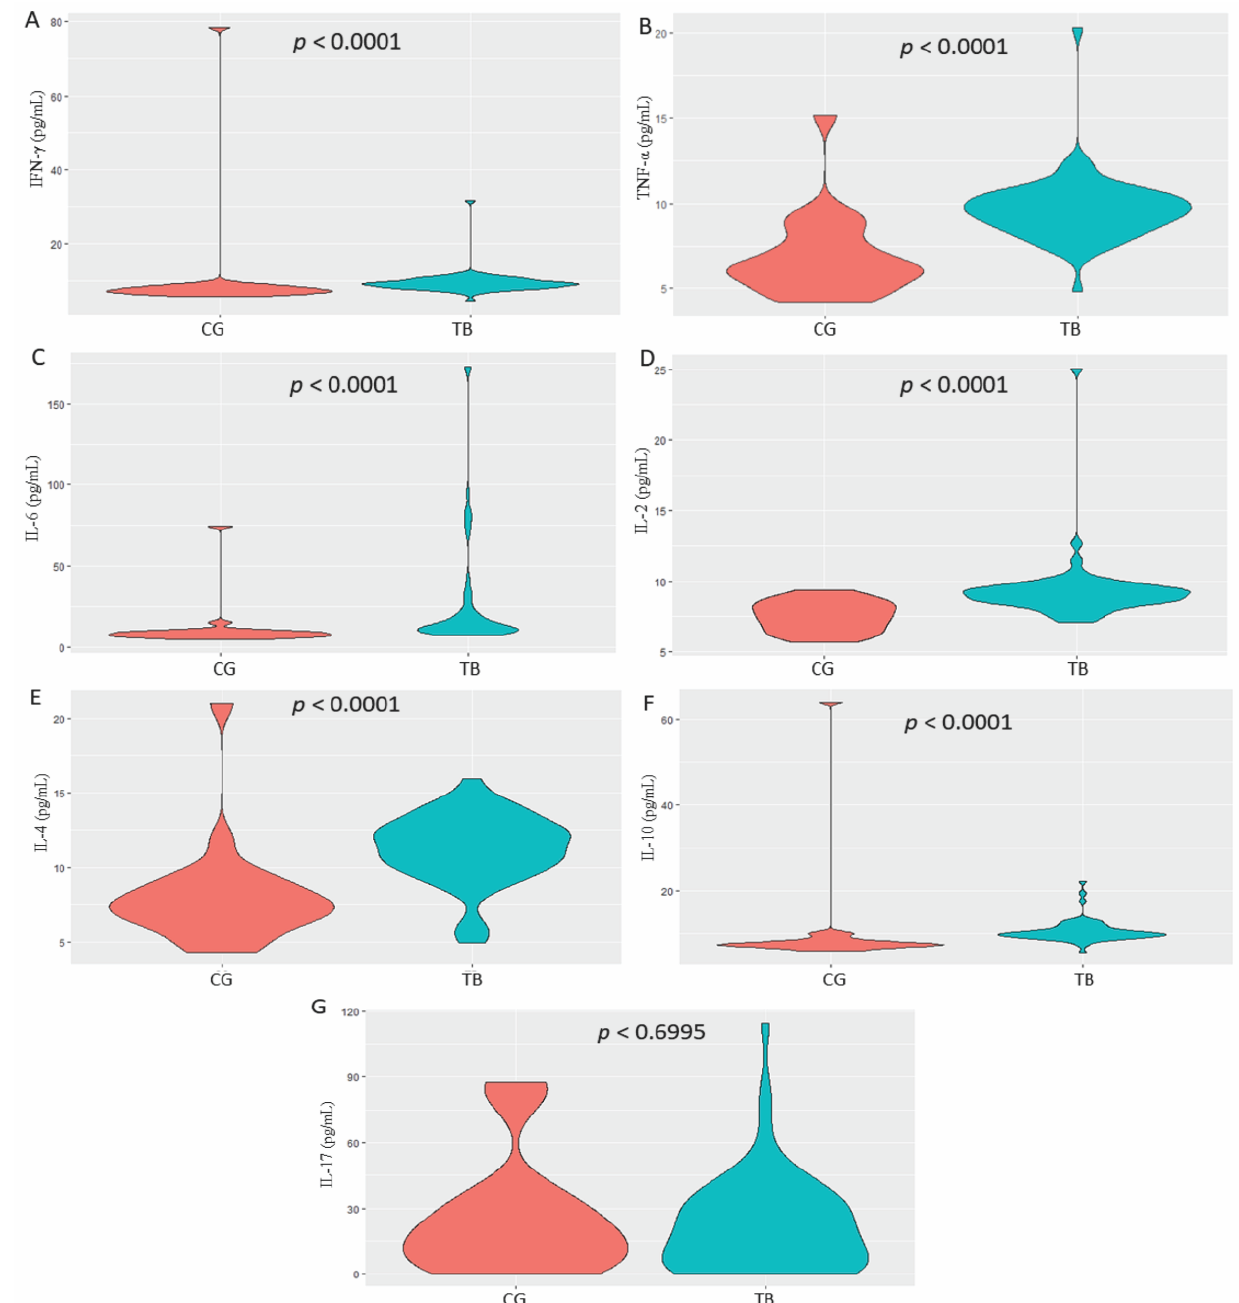
Figure 1. Comparison of: ( A ) IFN- γ ; ( B ) TNF- α ; ( C ) IL-6; ( D ) IL-2; ( E ) IL-4; ( F ) IL-10; and ( G ) IL-17 levels between the control group (CG) and tuberculosis (TB) group. Mann–Whitney test.